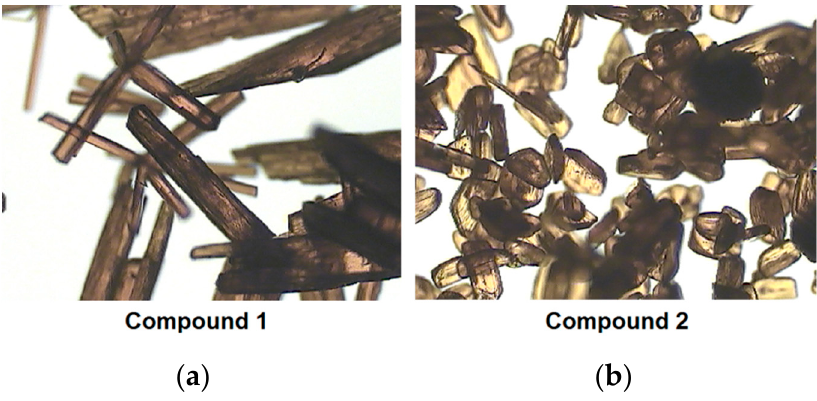
Figure 5. Images of crystal morphologies observed by optical stereoscopic microscope. ( a ) (DMAPH) 6 [V 10 O 28 ]·H 2 O; ( b ) (DMAPH) 6 [V 10 O 28 ]·16H 2